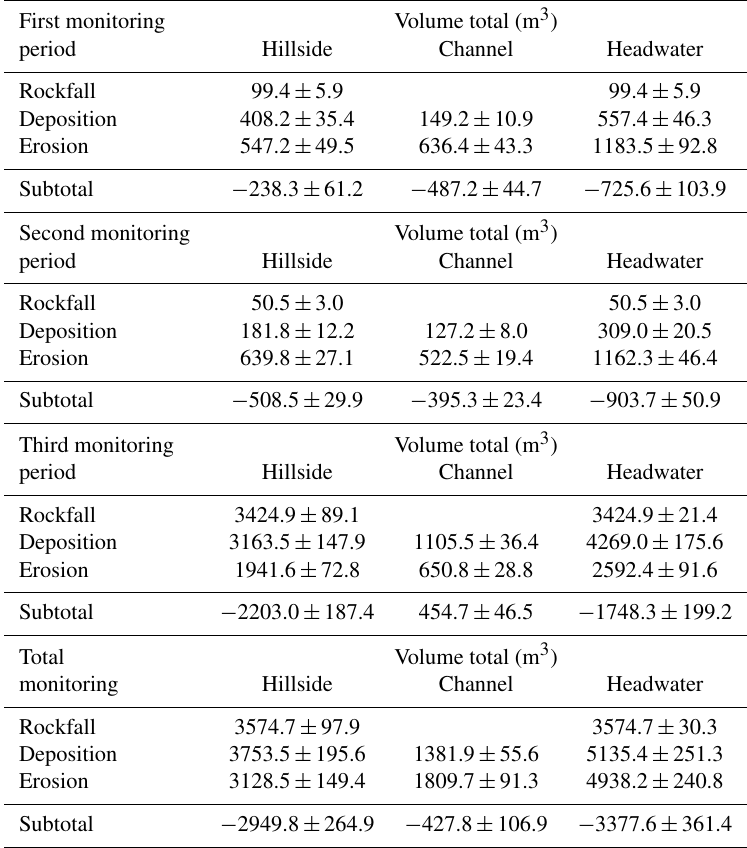
Table 5. Overall headwater sediment budget recorded during the three survey periods and net sediment balance of the 16 months of moni- toring. Sediment budgets for each catchment subsystem are detailed in the